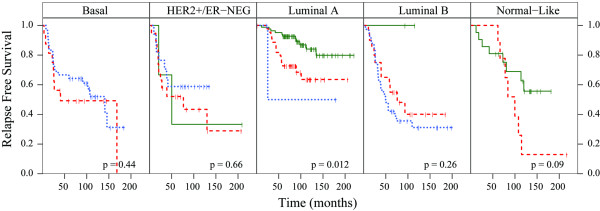
Stratification of five 'intrinsic' subtypes by the proliferation meta-gene. A large microarray breast cancer data set (337 samples × 16,000 genes) from women with early-stage disease was used to confirm the significance of the proliferation meta-gene to further risk-stratify the Luminal tumors. Tumors were classified as Basal, HER2+/ER-, Luminal A, Luminal B, and Normal-like. The microarray data for the proliferation meta-gene was then used in a Cox regression model to determine probability of relapse in women with the different tumor subtypes. Differences in relapse for low (green), medium (red), and high (blue) expression are shown as tertiles in the Kaplan-Meier plots. The Kaplan-Meier curves show that proliferation adds significant survival information, beyond that gleaned from the intrinsic subtype, only for patients with Luminal A tumors (P = 0.012).